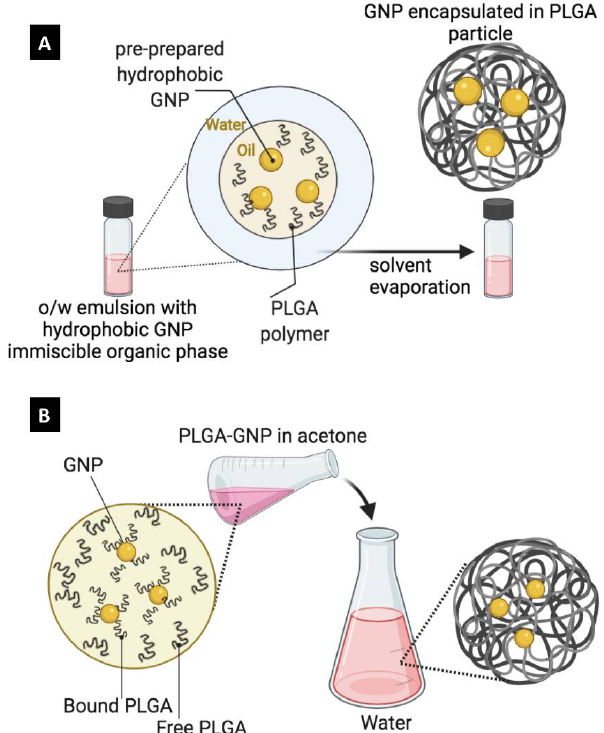
Figure 5. Labeling poly(lactic-co-glycolic acid) (PLGA) particles with GNP. ( A ) o/w emulsion method in which pre-prepared hydrophobic GNP is suspended in the internal organic phase with PLGA polymers (Emulsion-evaporation method). ( B ) Co-precipitation of pre-prepared hydrophobic GNP and PLGA polymer from the use of a water-miscible organic solvent upon addition to aqueous system (nanoprecipitation method).